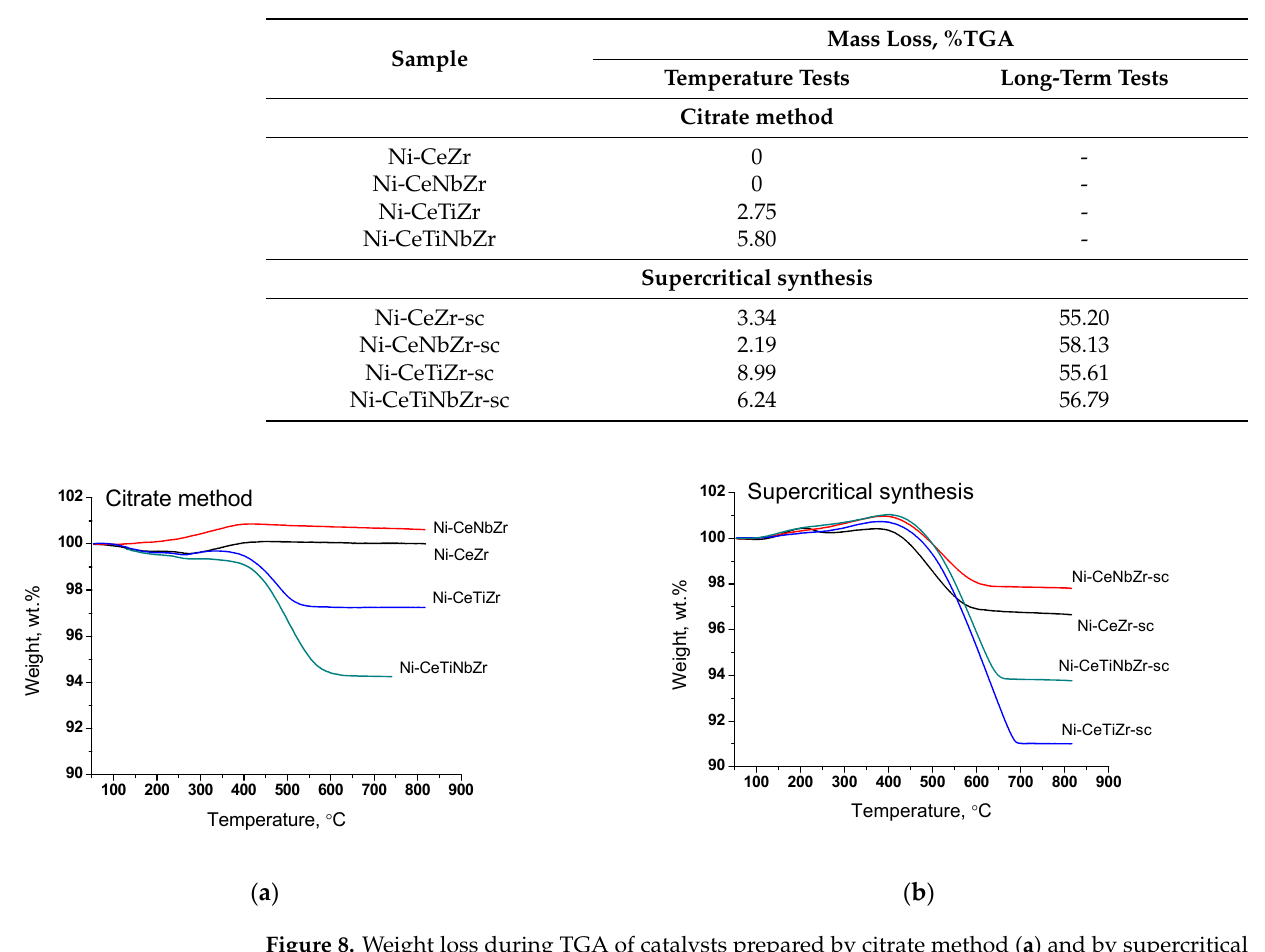
Table 7. Weight loss during TGA of spent catalysts.